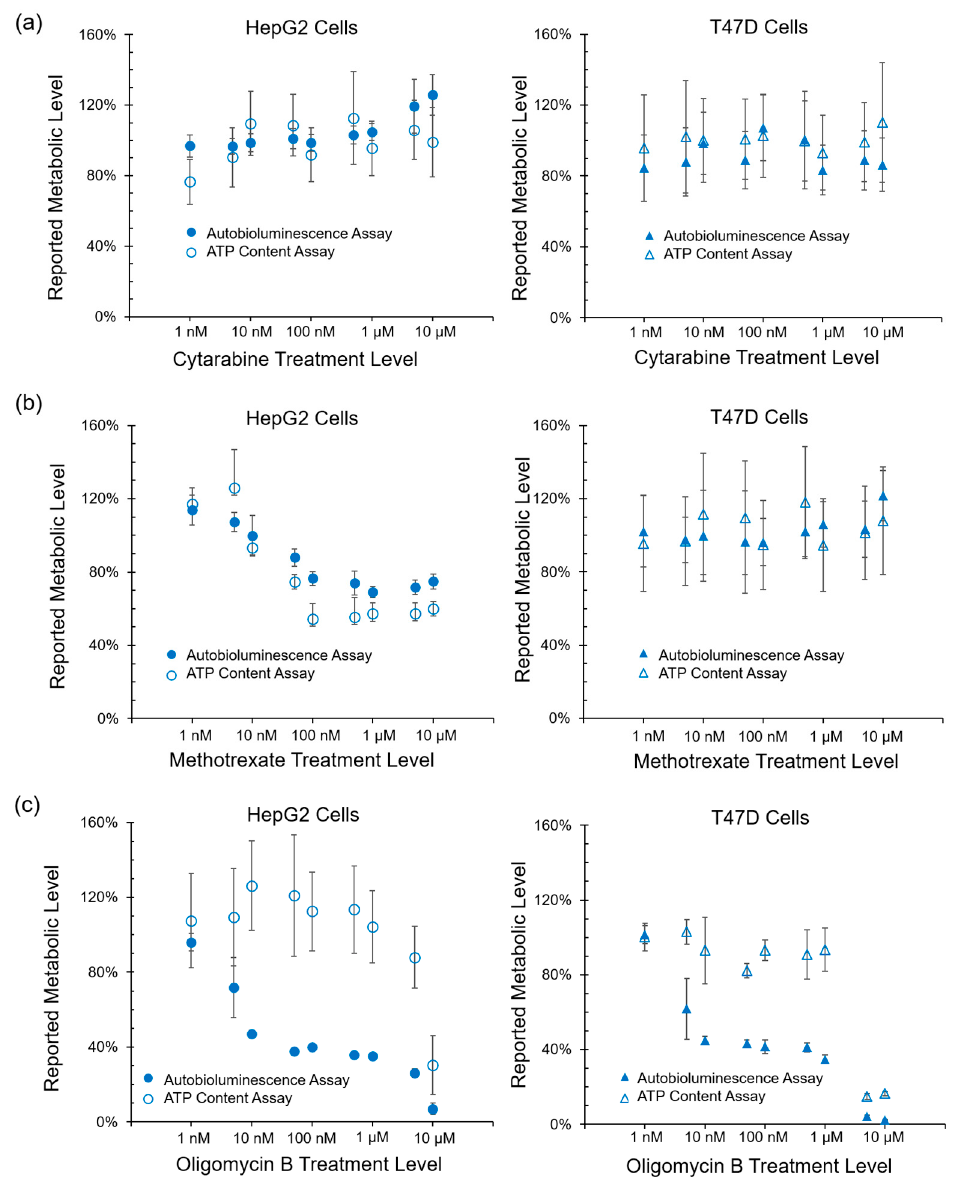
Figure 2. Detection of metabolic impact using autobioluminescence correlated with ATP content for both ( a ) Cytarabine and ( b ) Methotrexate, and was more sensitive for the detection of ( c ) Oligomycin B. Values are the averages of triplicate tests, with error represented as SEM.